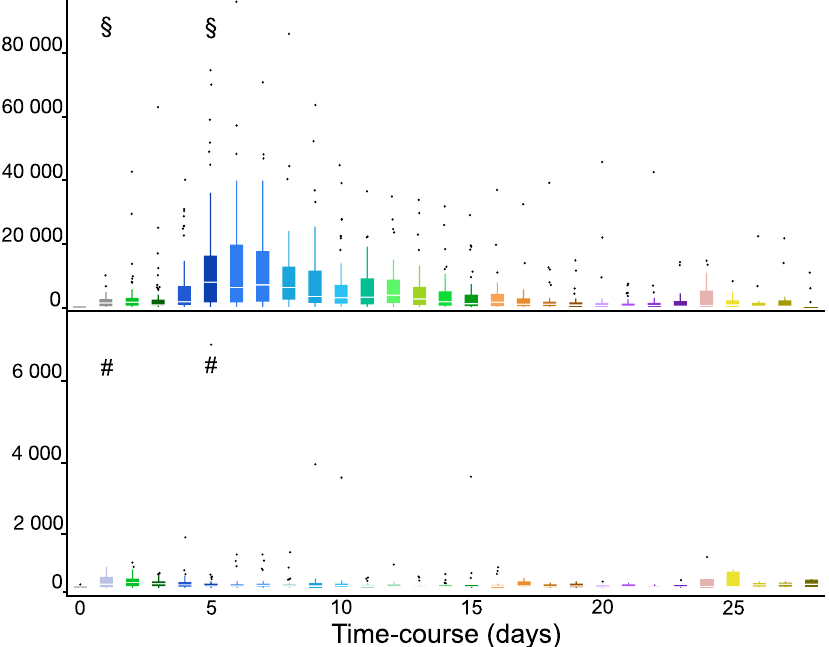
Figure 1. Interleukin 6 CSF and serum levels following aneurysmal SAH. CSF and blood serum IL-6 levels from day 0 to day 28 are depicted as box plots. The median is marked by the white notch within the quartiles. Outliers are plotted as individual points. IL-6 CSF levels ( a ) were distinctly higher than serum levels ( b ) throughout the study period. There was a significant increase over the first few days and the peak median CSF IL-6 value was observed at day 5 after subarachnoid hemorrhage (§ in 1a; day 5 vs. day 1, P < 0.01). No corresponding peak was seen for serum IL-6 levels (# in 1b; day 5 vs. day 1, P =